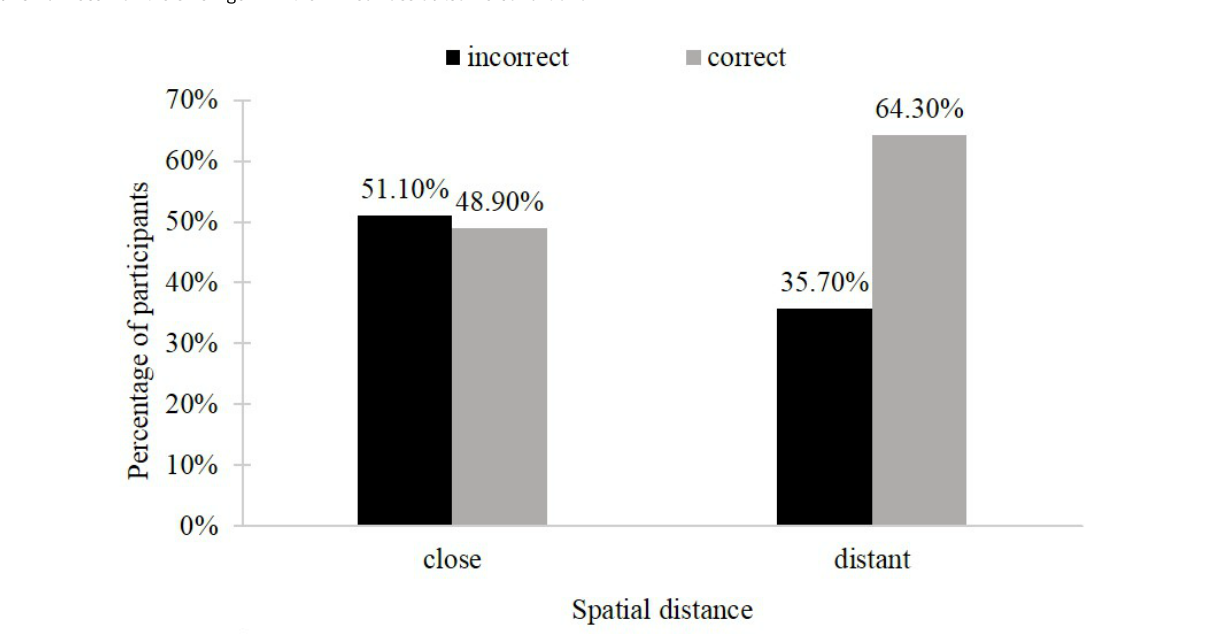
Figure 4. Recall of the small gain in the mixed-loss outcome